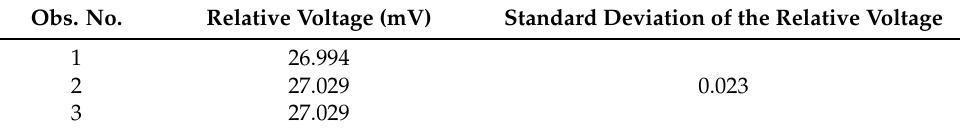
concentration for the three measurements of three specimens of Nile-red-containing sensing membrane.